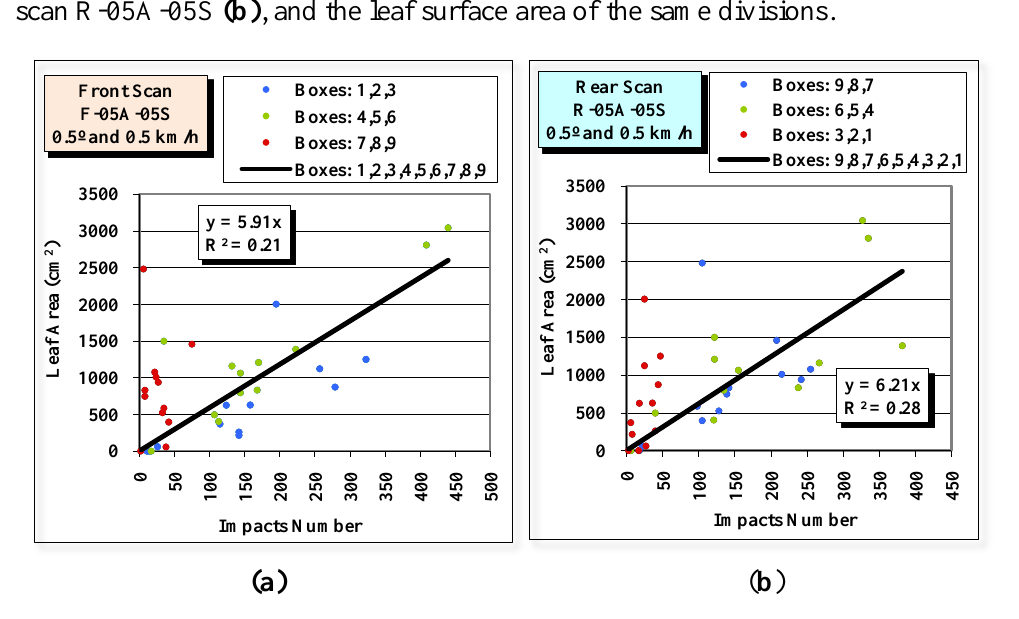
Figure 13. Scatter diagrams, regression lines and R 2 of the relation between the number of impacts received in the 36 divisions (boxes) in the front view scan F-05A-05S (a) and rear view scan R-05A-05S (b) , and the leaf surface area of the same